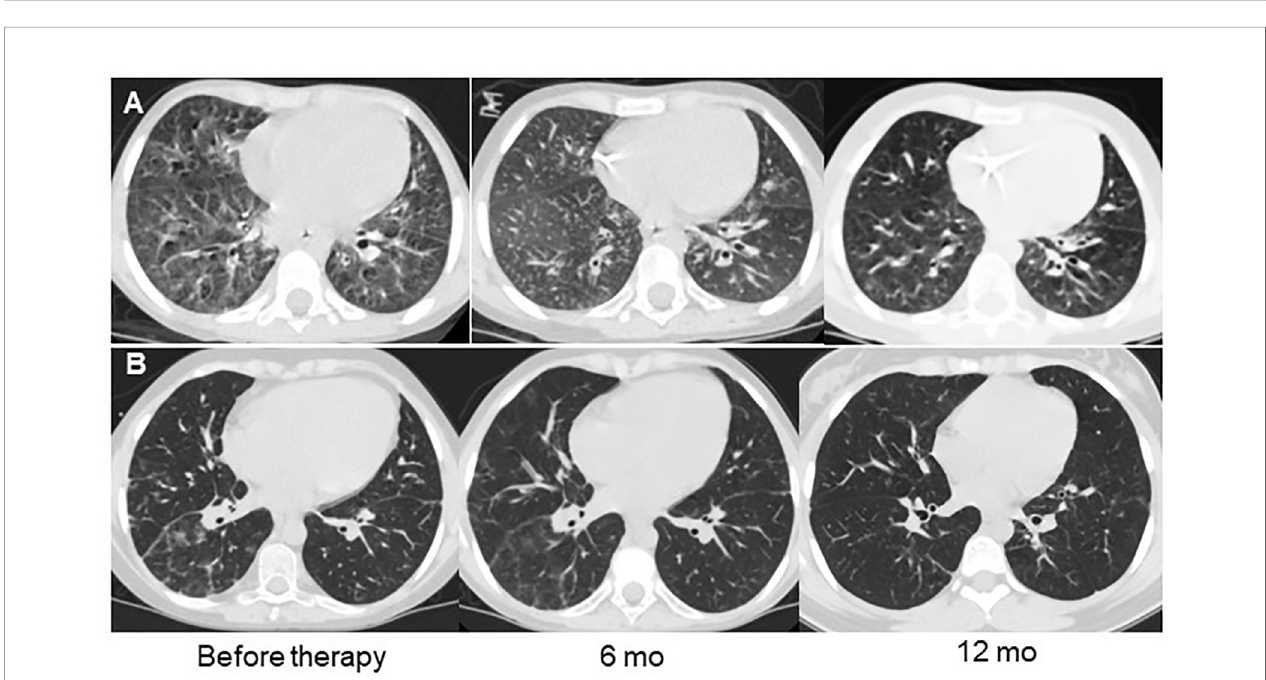
FIGURE 4 | Dynamics of clinical and radiological symptoms in patients treated with abatacept. (A) Cough, (B) wheezing, (C) dyspnea, (D) CT changes.